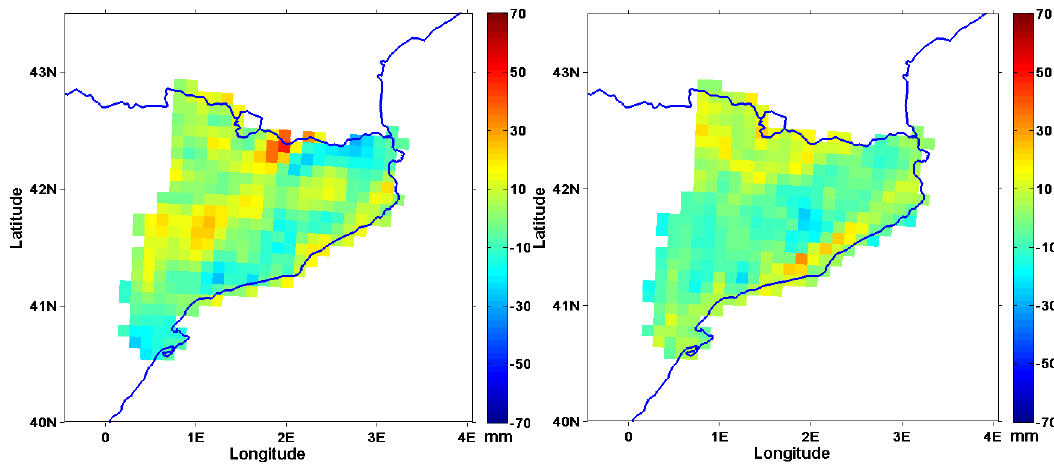
Fig. 18. Rainfall prediction bias fields over Catalonia for MM5’s (left) and COSMO-I7’s (right) QPFs for case study 5. Figure 18. Rainfall prediction bias fields over Catalonia for MM5‟s (left) and COSMO- 3 undertaken between the MM5 and COSMO-I7 models for I7‟s (right) QPFs for case study 5. 4 these cases. SMC’s simplified probabilistic forecasts at